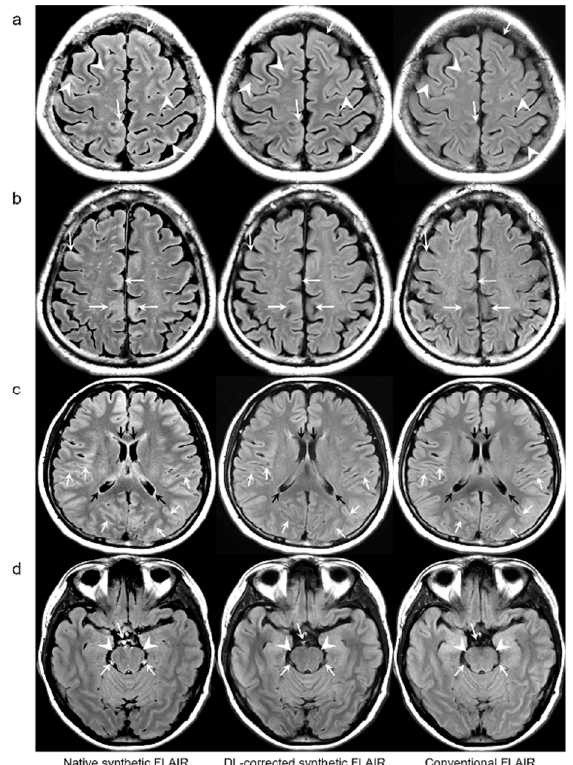
Figure 2. Representative results of synthetic fluid-attenuated inversion recovery (FLAIR) artifact reduction. Pairs of native synthetic FLAIR, deep learning (DL)-FLAIR, and conventional FLAIR